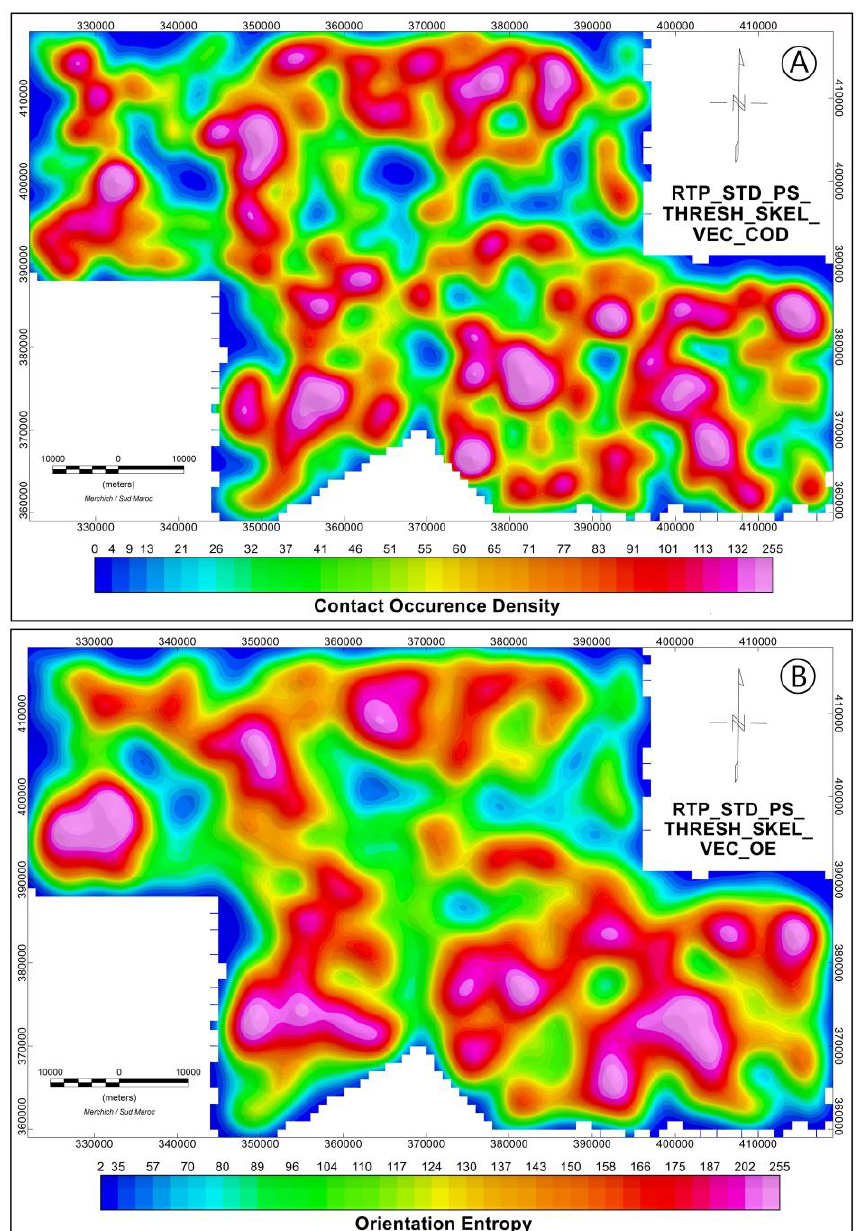
Figure 14. ( A ) Contact occurrence density map (structural complexity). ( B ) Orientation entropy map.